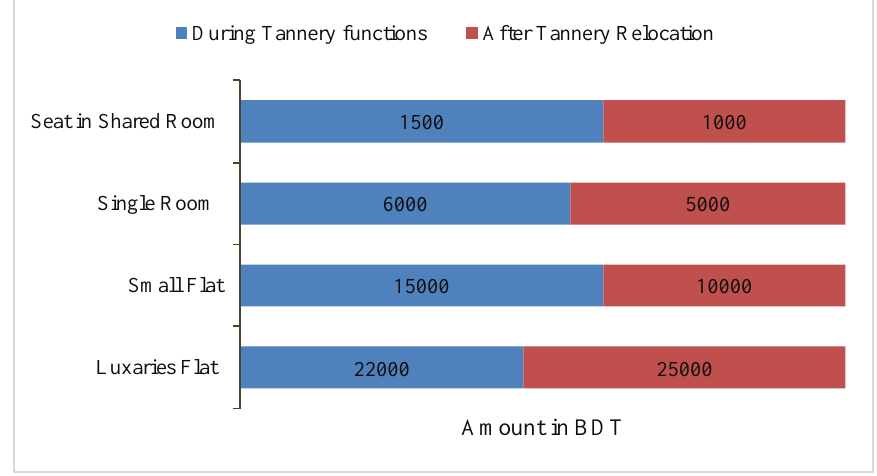
Figure 5: Change in House Rent in Hazaribag